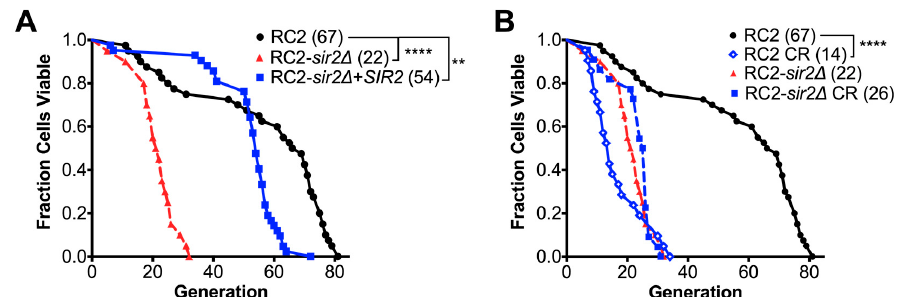
Figure 2. CR mediated loss of replicative lifespan was not mediated or affected by SIR2 in strain RC2. ( A ) Median RLS of RC2 -sir2 Δ cells was significantly shortened by 68% compared to wt. The loss of